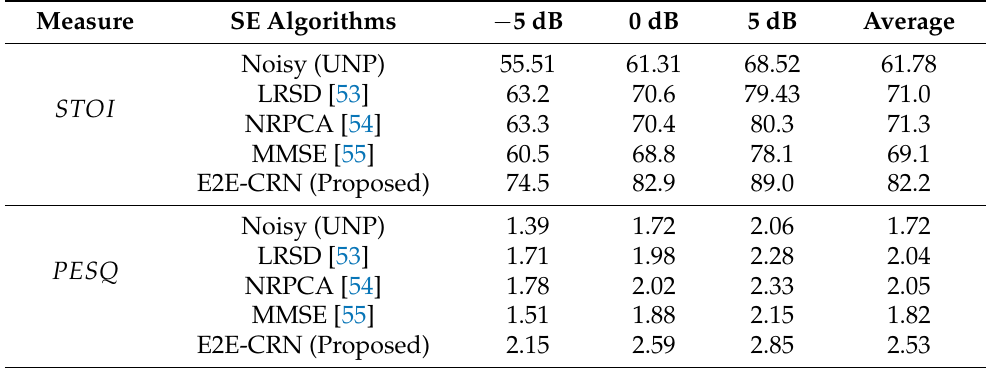
Table 7. Comparison against Unsupervised Deep